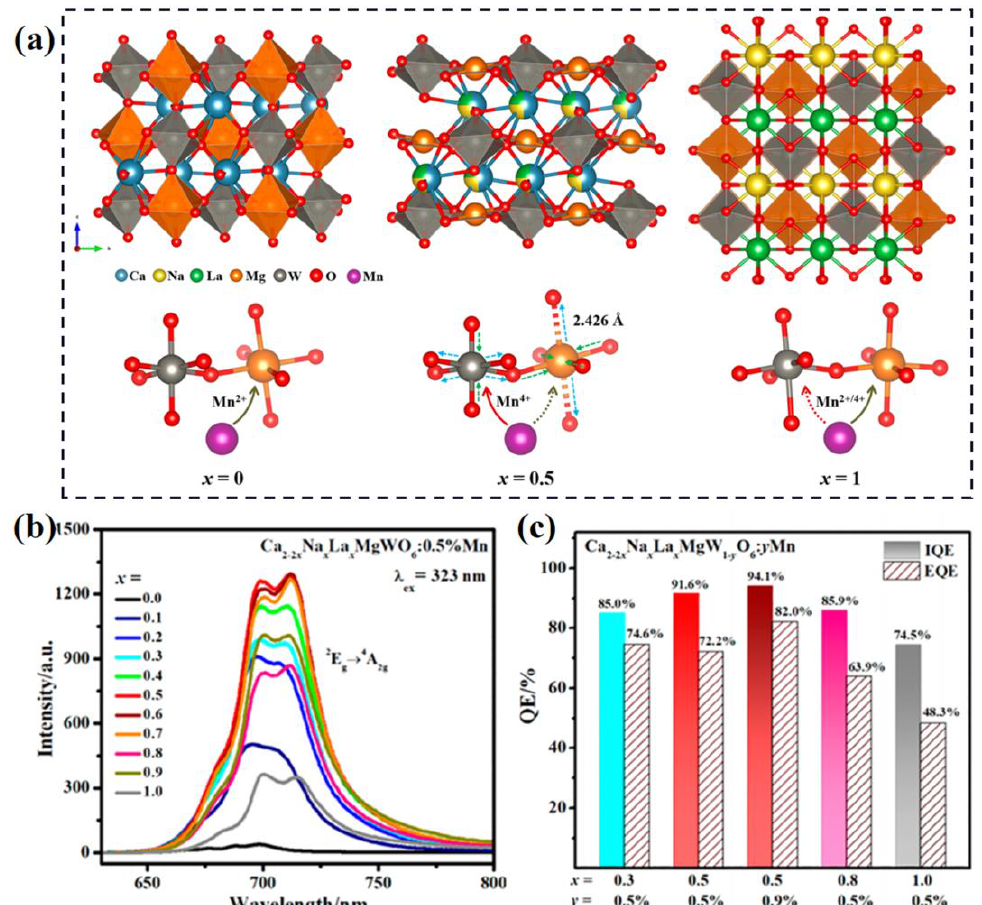
Figure 8. ( a ) Crystal structure diagram of Ca 2 − 2x Na x La x MgWO 6 (x = 0, 0.5, 1.0), and the schematic diagram of site occupancy preference of Mn and the resulting +2/+4 valence stability. ( b ) The PL spectra and ( c ) QE values of Ca 2 − 2x Na x La x MgWO 6 :Mn samples. Reprinted with permission from ref. [84]. Copyright 2022 American Chemical Society.